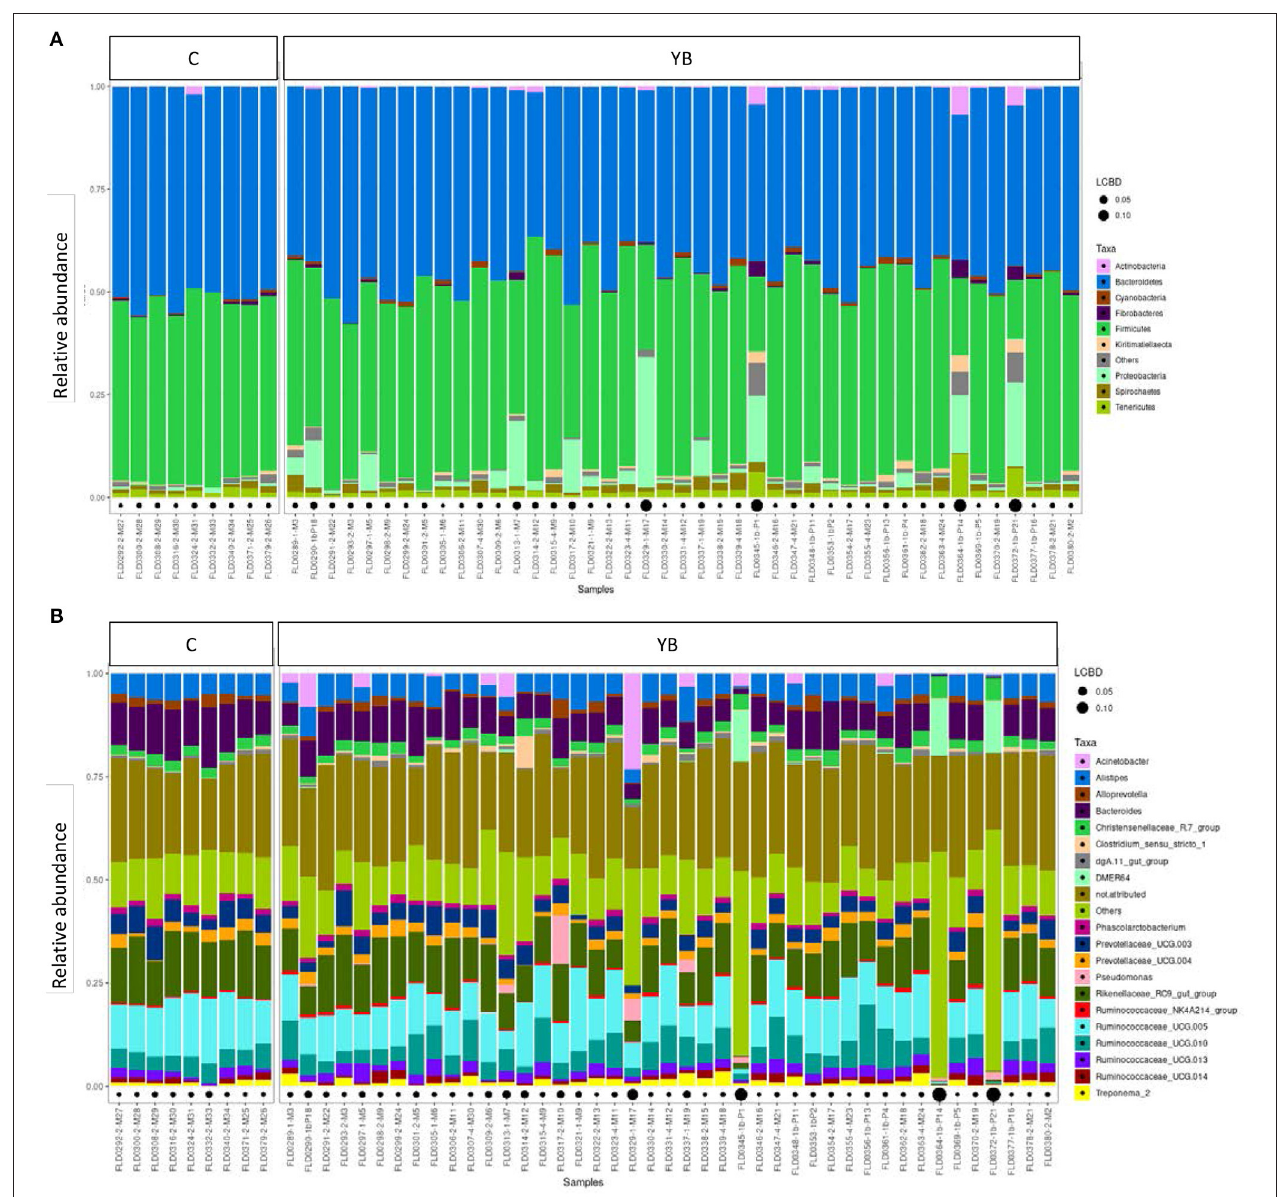
FIGURE 2 | Taxonomic profiles of the fecal bacteria from dairy cows (C) and young bulls (YB). (A) Bar plot representation of relative proportion of the nine major phyla in the fecal samples. (B) Bar plot representation of relative proportion of the 20 major genera in the fecal samples. Black points size is proportional to the local contribution to beta diversity for each